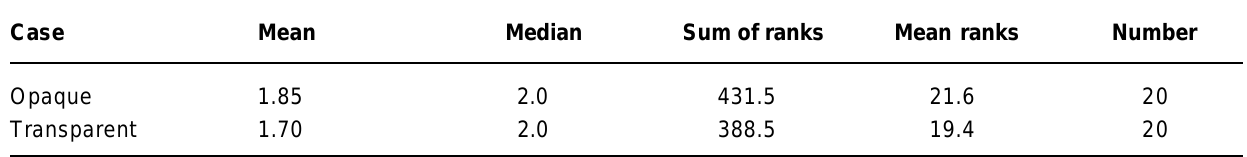
U=178.5. Normal approximation: Z=0.83688636; Probability = 0.40265645 (non